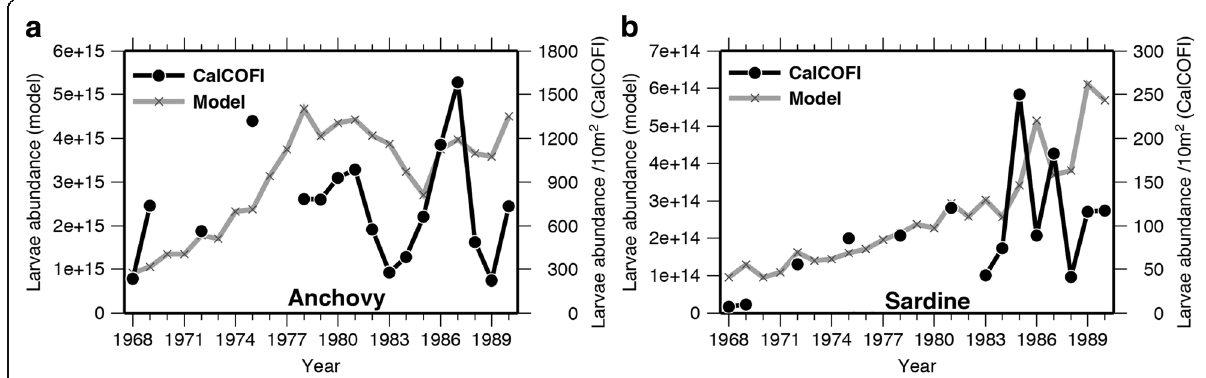
Fig. 3 Comparison between model simulation results and field data for larval abundances. Time series of the larval abundance generated by the climate-to-fishery model (black line with closed circles) and from CALCOFI field data (gray line with open circles) for a anchovy and for b sardine